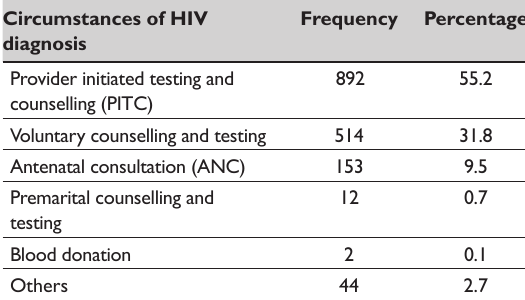
Table 3: Circumstance leading to HIV